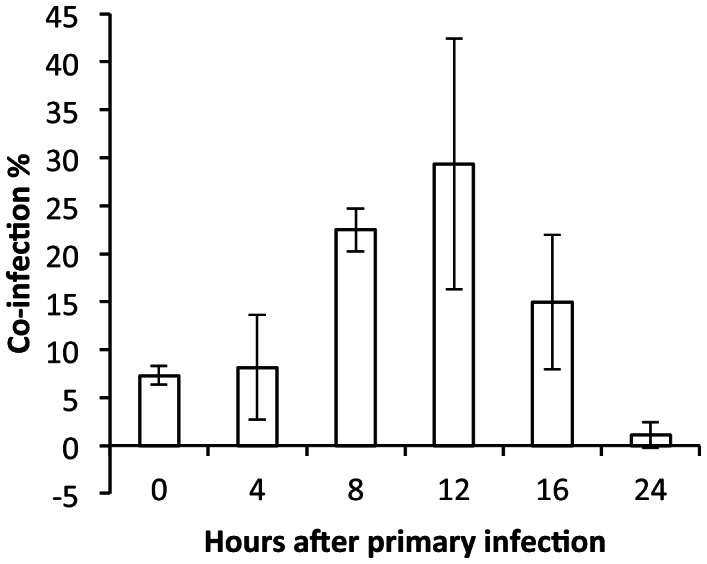
Viral spread in cell culture leads to increased frequency of co-infected cells when super-infection is delayed by 8 or 12 hours.MDCK cells were infected in the presence of trypsin at an MOI of 0.01 PFU/cell with each virus, simultaneously (0 h), or first with the var virus and then with the wt virus at the times indicated. Cell monolayers were collected and processed for flow cytometry 12 h after the wt virus infection. The average (n = 3) percentage of infected cells that were co-infected is plotted. Error bars indicate standard deviation.